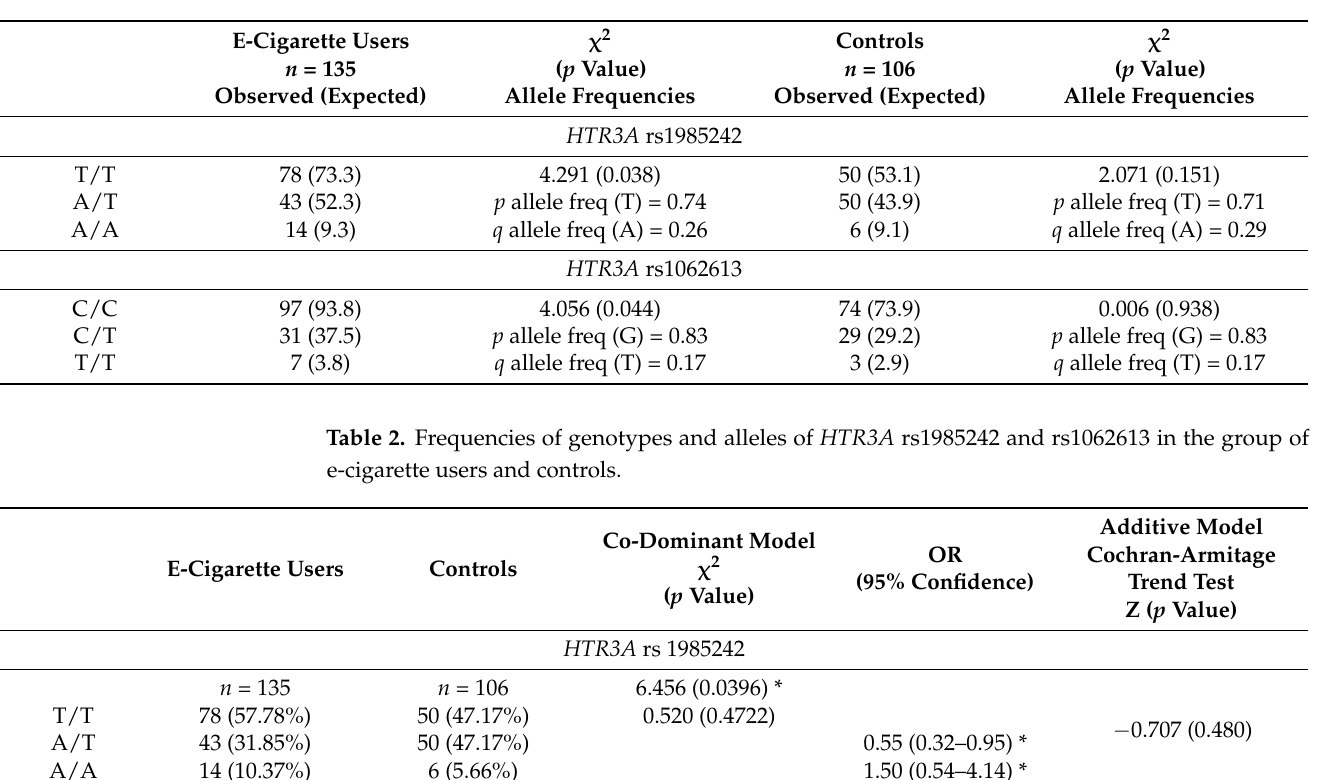
Table 1. Hardy–Weinberg equilibrium of the HTR3A rs1985242 and rs1062613 in the group of e-cigarette users and controls.